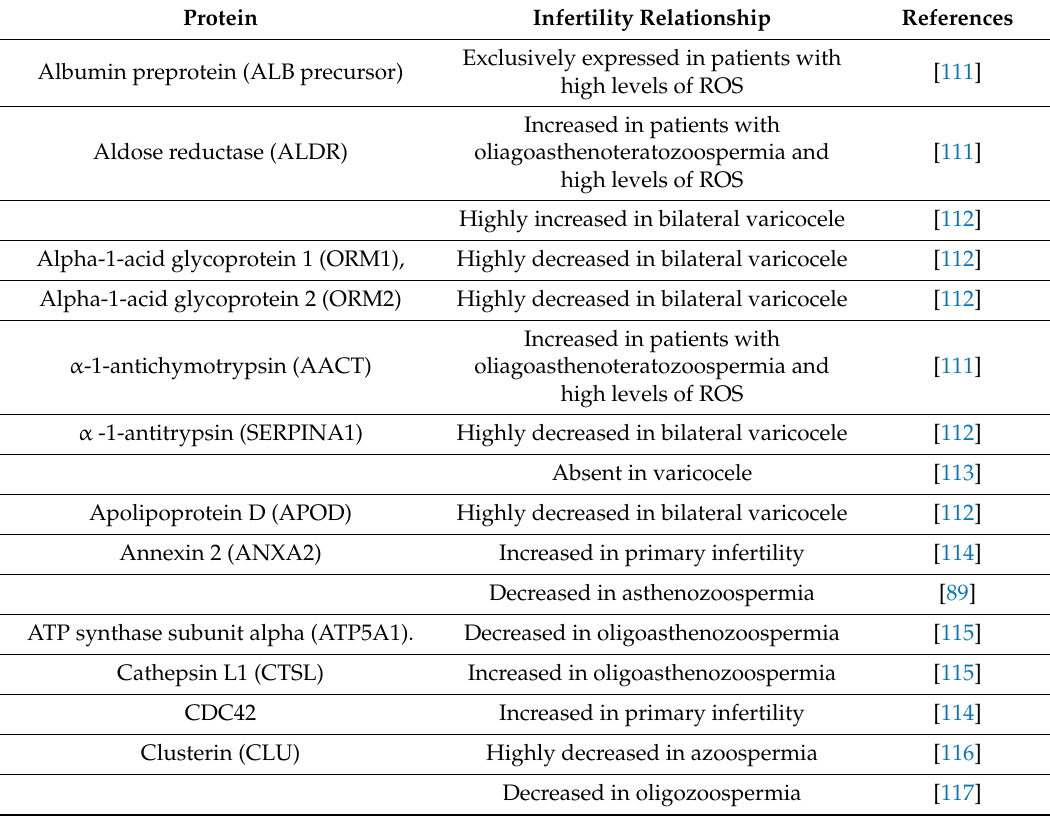
Table 1. Representative SP proteins proposed as biomarkers of male infertility. Protein Infertility